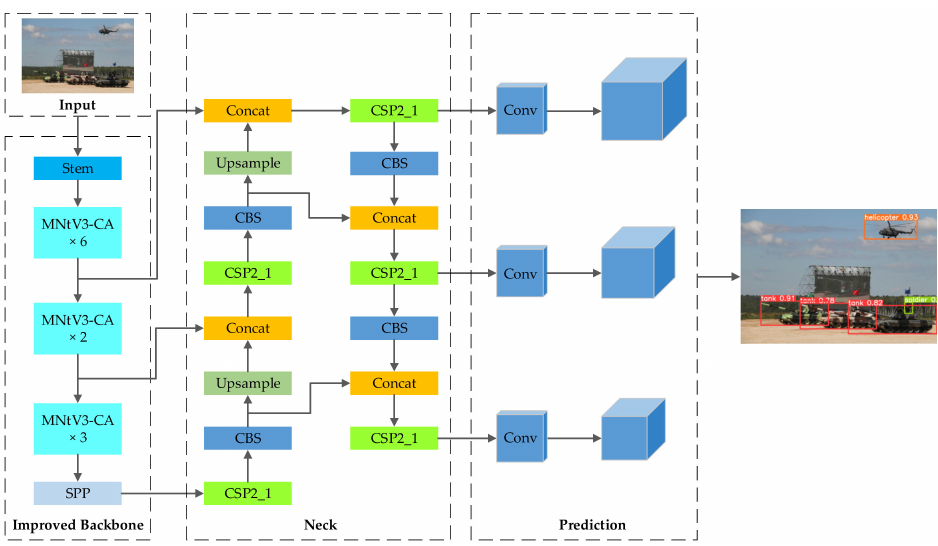
Figure 7. The network structure of SMCA- α